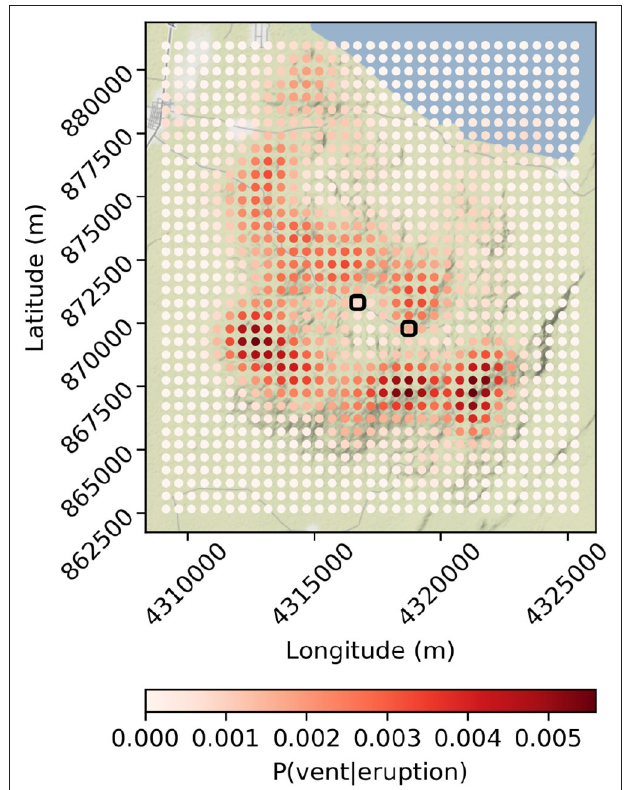
eruption ), using the |